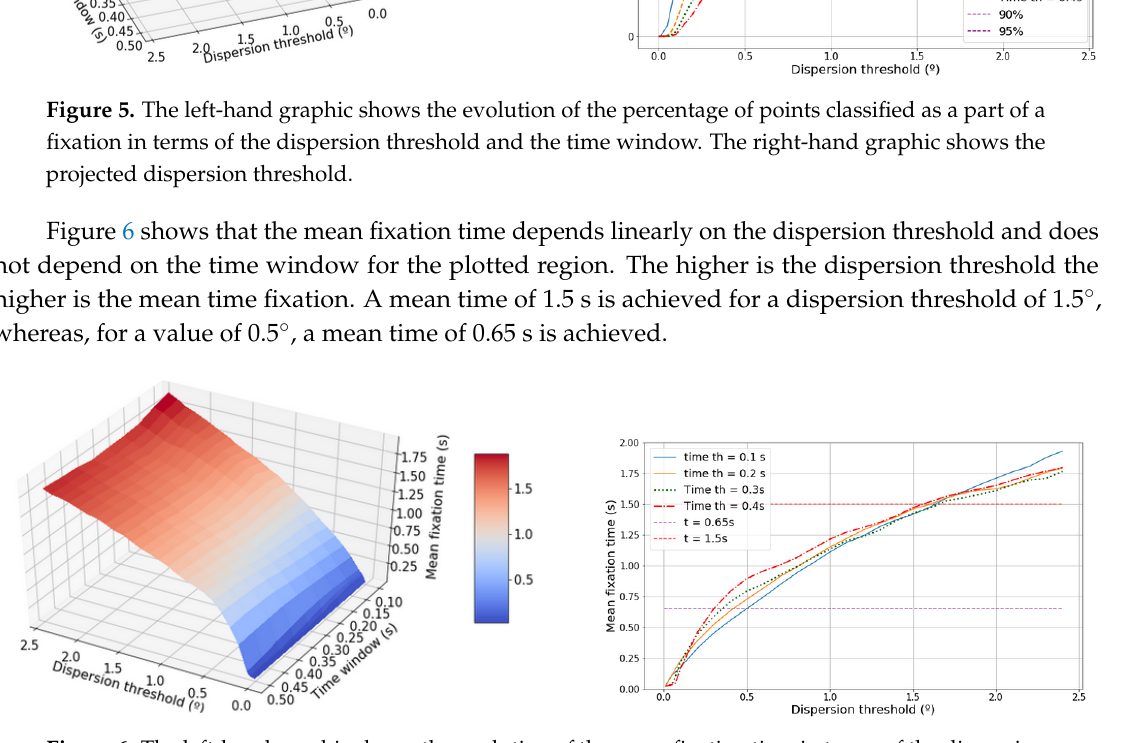
Figure 6. The left-hand graphic shows the evolution of the mean fixation time in terms of the dispersion threshold and the time window. The right-hand graphic shows the projected dispersion